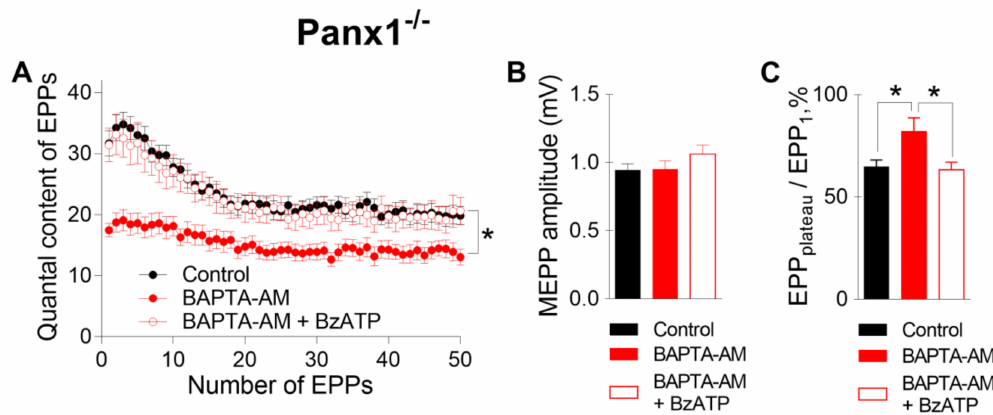
Figure 5. The activation of P2X7 receptors restored the decrease in evoked neuromuscular transmission at the NMJs of Panx1 − / − mice induced by incubation with a fast Ca 2 + chelator. ( A ) Changes in the EPP quantal content in the control group (n = 22), after incubation with BAPTA-AM (50 µ M) (n = 17) and during the subsequent activation of P2X7 receptors by their agonist BzATP (30 µ M) (n = 15). ( B ) MEPP amplitude in the control group, after incubation with BAPTA-AM and during the subsequent application of BzATP. ( C ) The ratio of the average quantal content of the last ten EPPs in the train to the quantal content of the first EPP (EPP plateau / EPP 1 ) normalized to EPP 1 (taken as 100%) in the control group, after incubation with BAPTA-AM and during the application of BzATP in the presence of preloaded BAPTA. The symbols, histograms and error bars represent the mean ± SEM. * p <